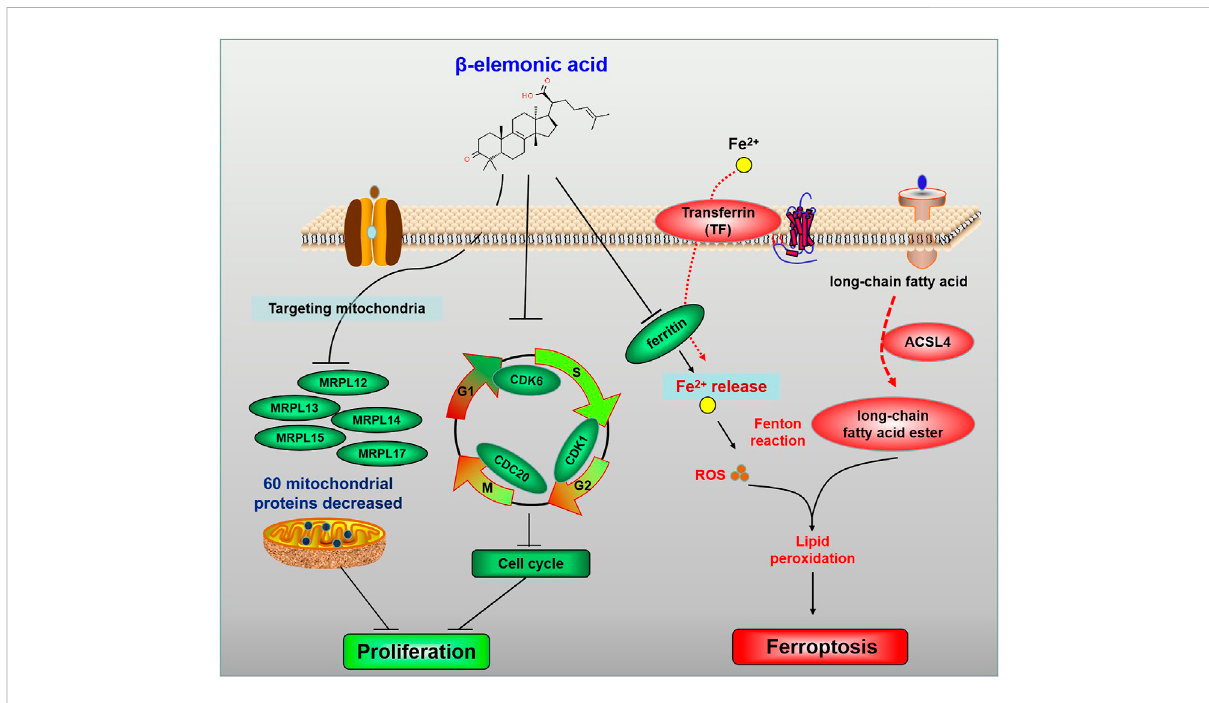
FIGURE 1 The schematic diagram for the molecular pharmacological mechanism of EA suppressing colorectal cancer (Xia et